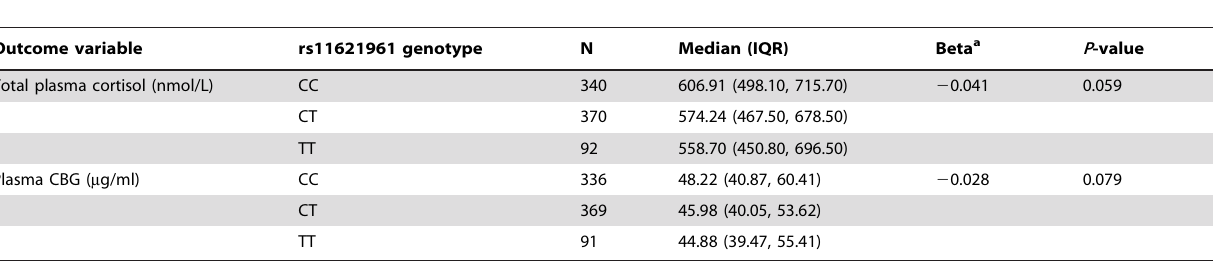
Table 4. Distribution of plasma total cortisol and CBG concentrations by genotype for SNP rs11621961, in SERPINA6 , identified in the HyperLasso Penalized Regression